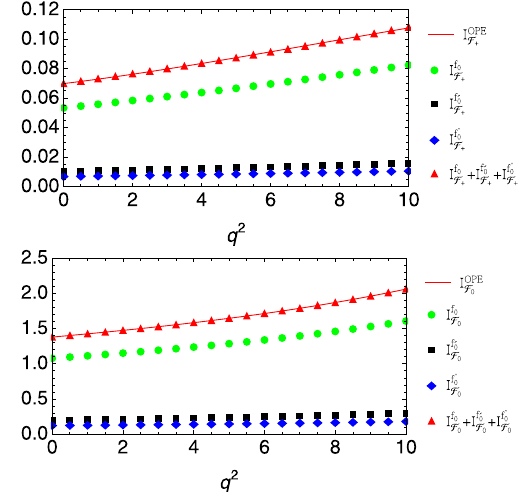
Fig. 3 The contributions to the OPE result I OPE F in the f 0 + f (cid:4)